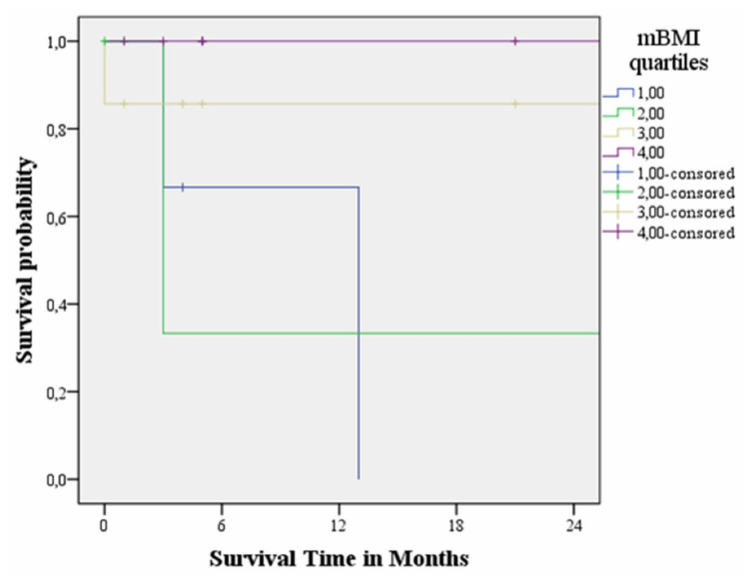
Figure 3. Kaplan-Meier survival curve analysis of cardiovascular mortality in ATTR group across the quartiles of the modified Body Mass